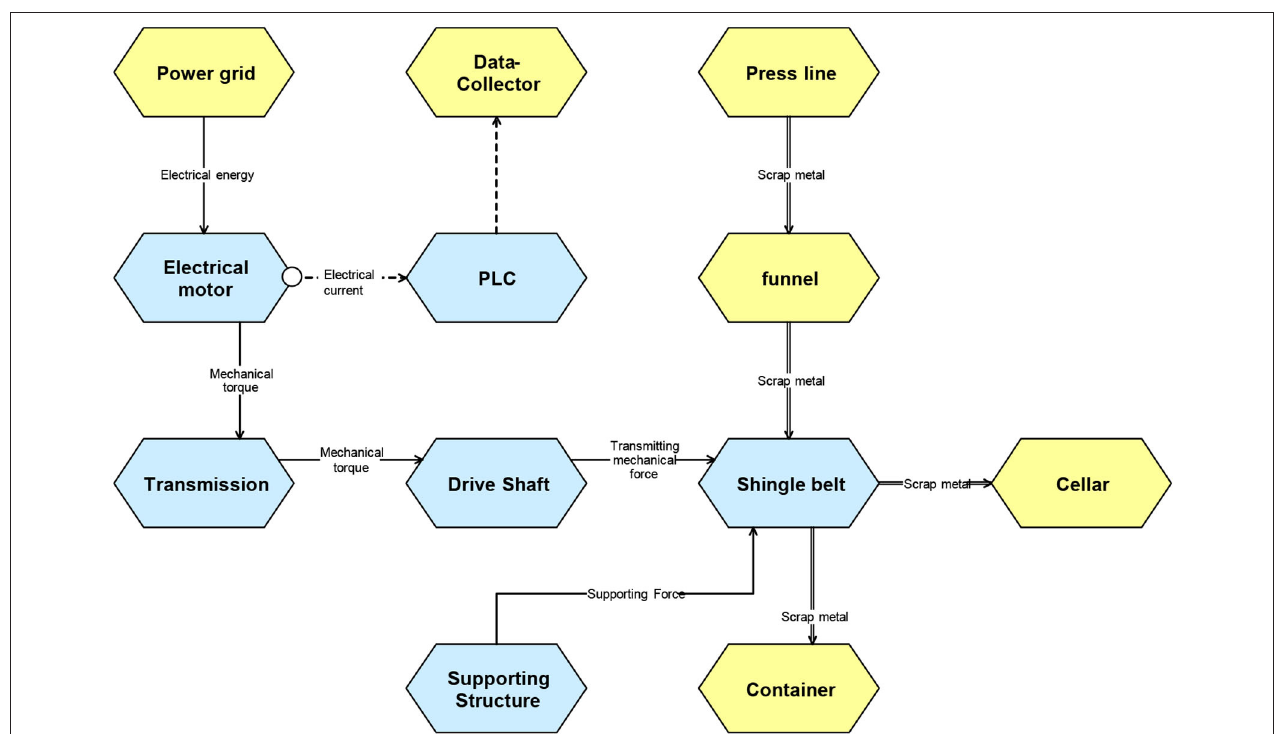
FIGURE 3 | Structure of the scrap